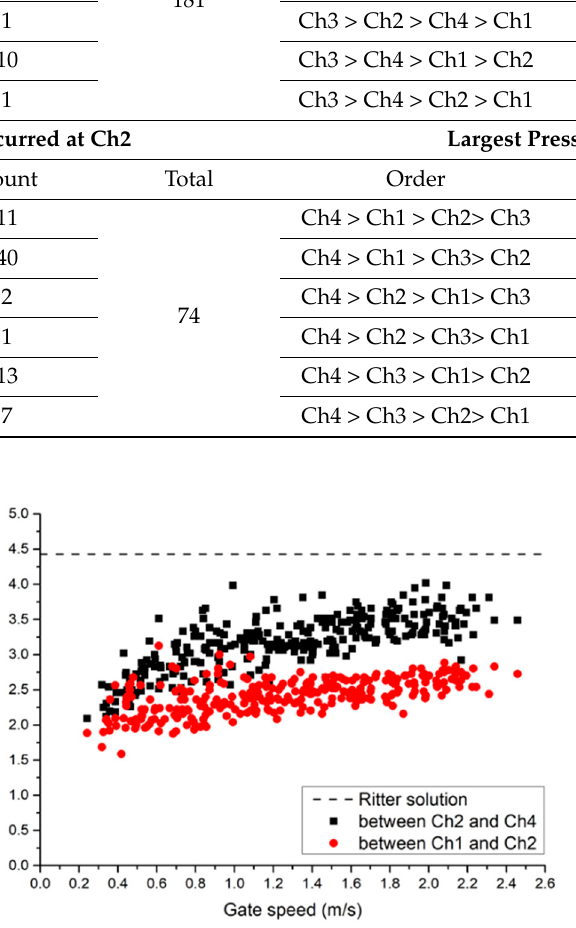
Figure 5. Wave speed comparison. The squares and circles represent the observed wave speeds and the dashed line represents the wave speed calculated with Ritter’s solution.